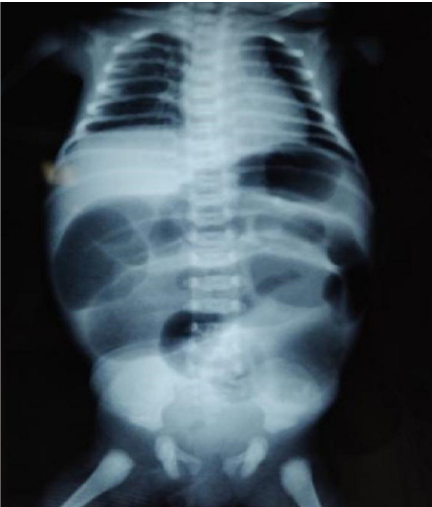
Figure 1. Plain abdominal radiograph showing